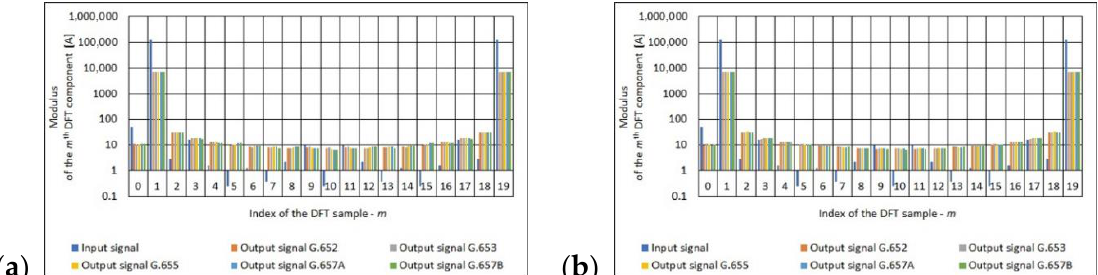
Figure 8. Values of the m th DFT input component (300 A True RMS) and output component for the different standards of single mode telecommunications fibers [own results]: ( a ) for 40-turns measuring coil and ( b ) for 80-turns measuring coil.